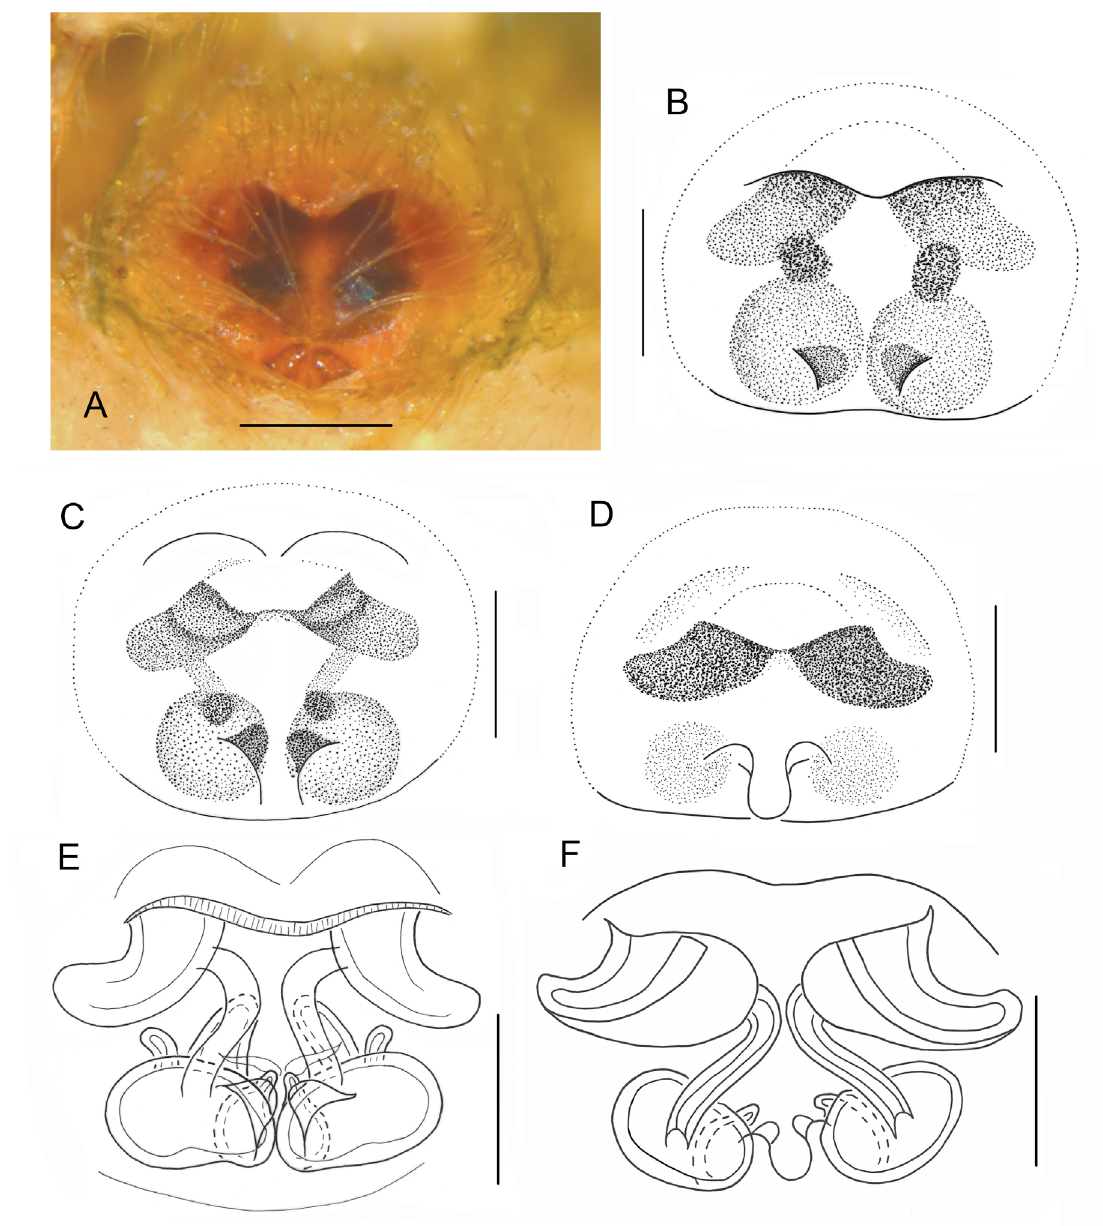
Fig. 6. Pochytoides obstipa sp. nov., paratypes, ♀. A–D . Epigyne. E–F . Internal structure of epigyne. scale bars: 0.2